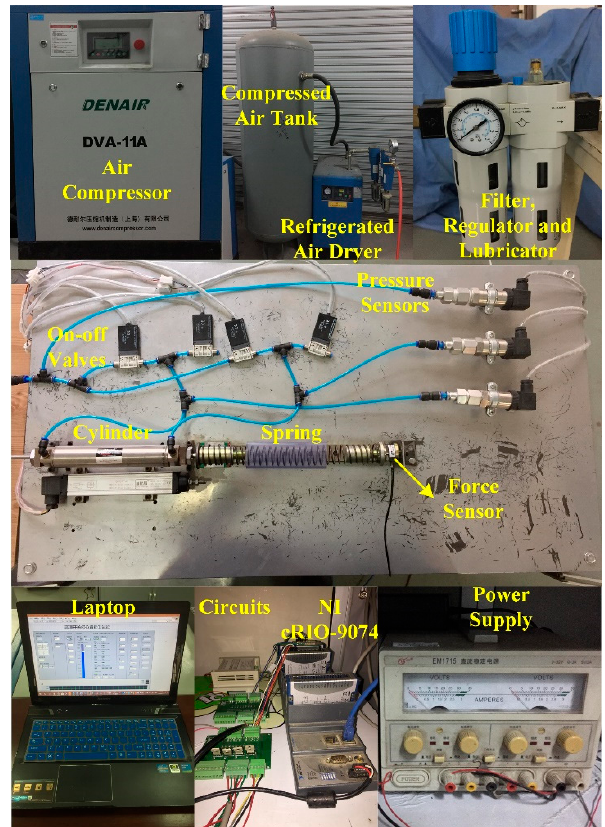
Figure 15. Pictures of the real system. Energies 2019 , 12 , x FOR PEER REVIEW